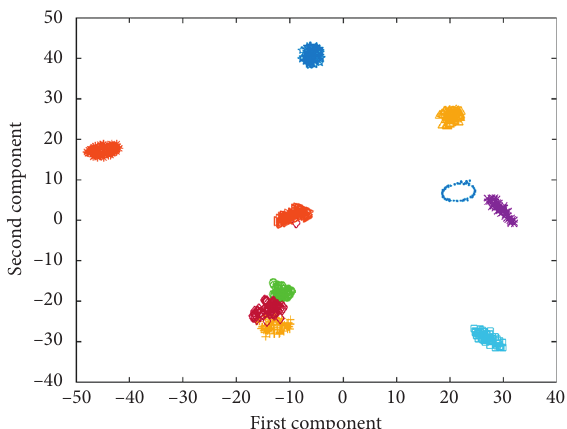
Figure 13: Visualization of 1% labeled sample.